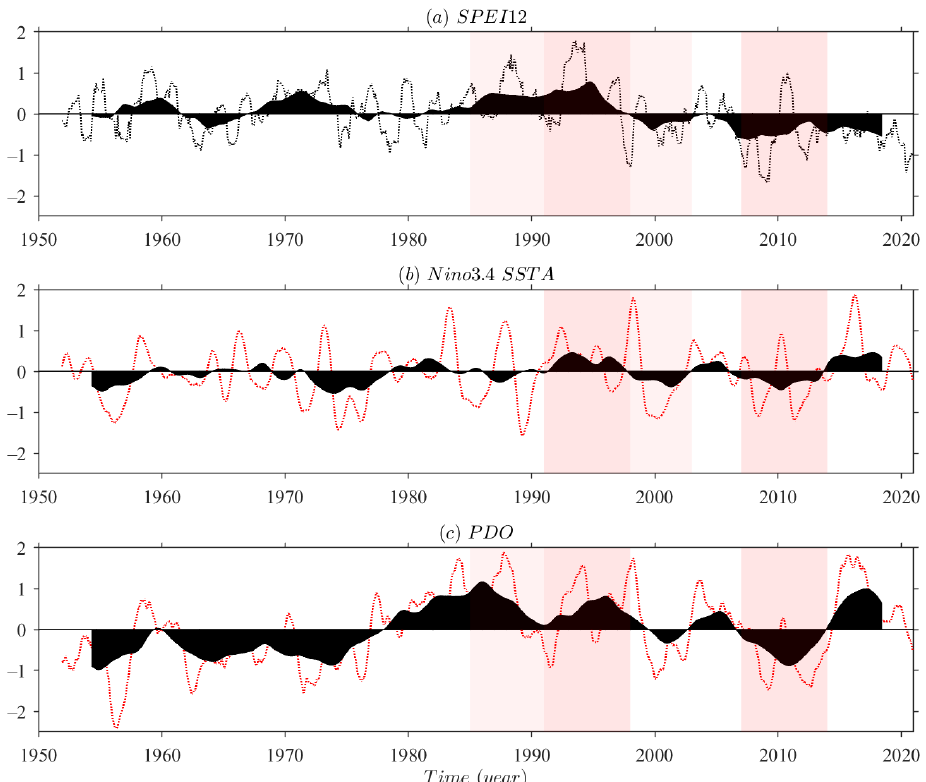
Figure 10. ( a ) Monthly SPEI series at 12-month time windows, ( b ) monthly sea surface temperature anomaly (SSTA) for NINO3.4 region, and ( c ) monthly series of Pacific Decadal Oscillation (PDO) index. Black shadow indicates the low-pass variability with applying a 60-month (5-year) moving average. Light red shaded areas indicate the periods when SPEI12 is in-phase with a single climate pattern, i.e., SPEI12+( − ) corresponds to ENSO+( − ) or PDO+( − ). Double-shaded areas indicate the periods when SPEI12 is in-phase with ENSO and PDO, i.e., SPEI12+( − ) corresponds to ENSO+( − ) and PDO+( −